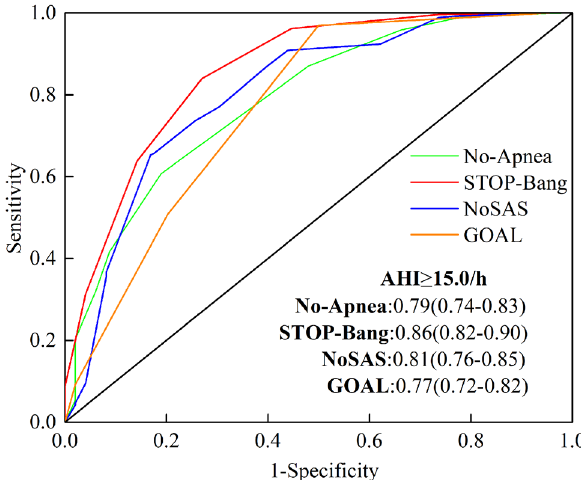
Figure 3. ROC curves of four screening tools (No-Apnea score, STOP-Bang questionnaire, NoSAS score and GOAL questionnaire) with an AHI cut-off ≥ 15 events/h. The area under the ROC curve (AUC) closer to 1 indicates the higher diagnostic accuracy of the screening questionnaire. AUC data are presented as values (95% confidence intervals). ROC receiver-operating curve, AHI apnea hypopnea index, AUC area under the curve.